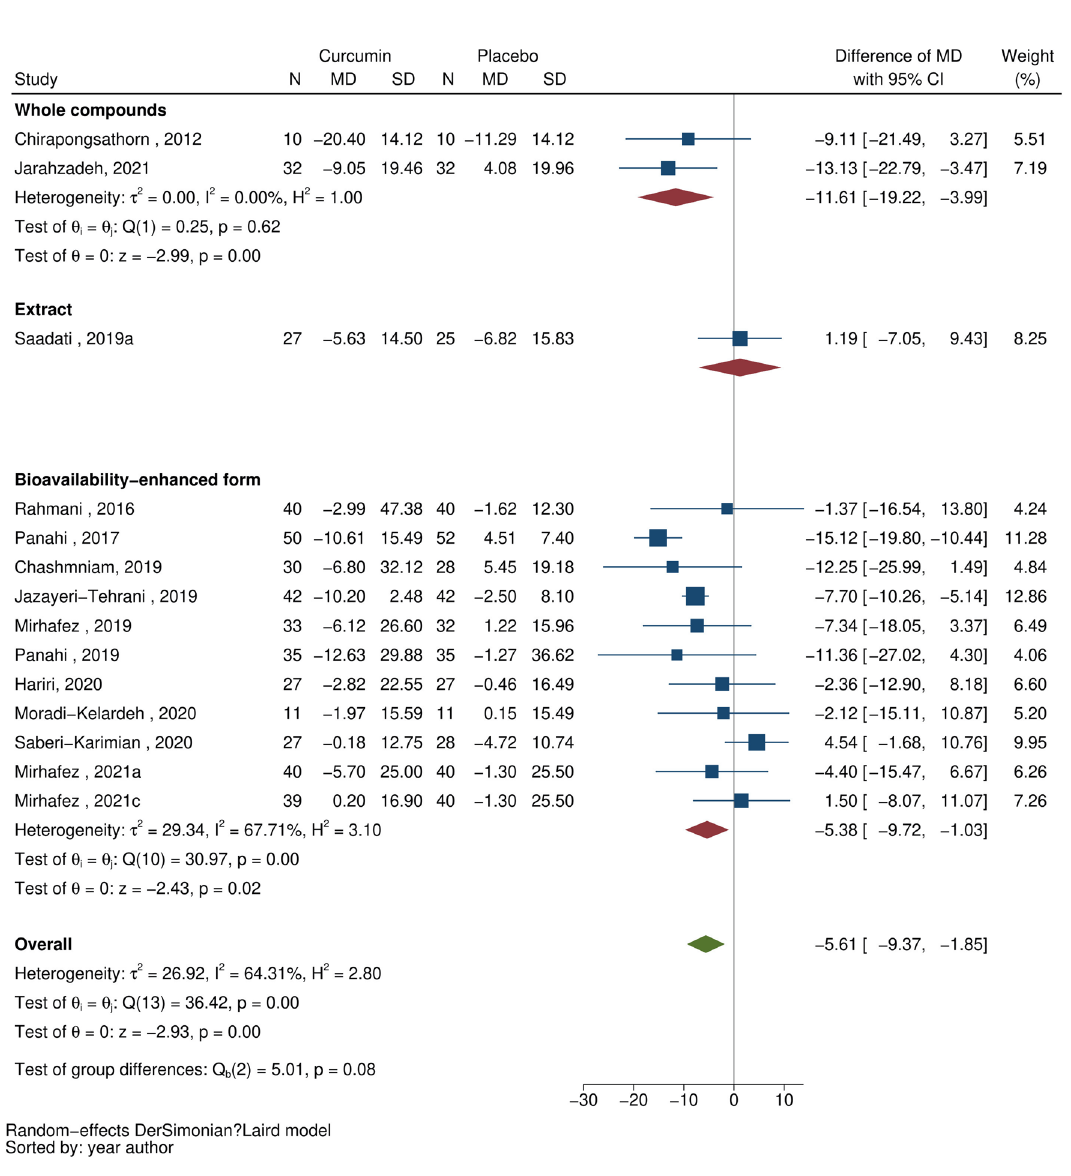
Figure 3. Forest plots demonstrating the effect of curcumin on alanine aminotransferase: all curcumin